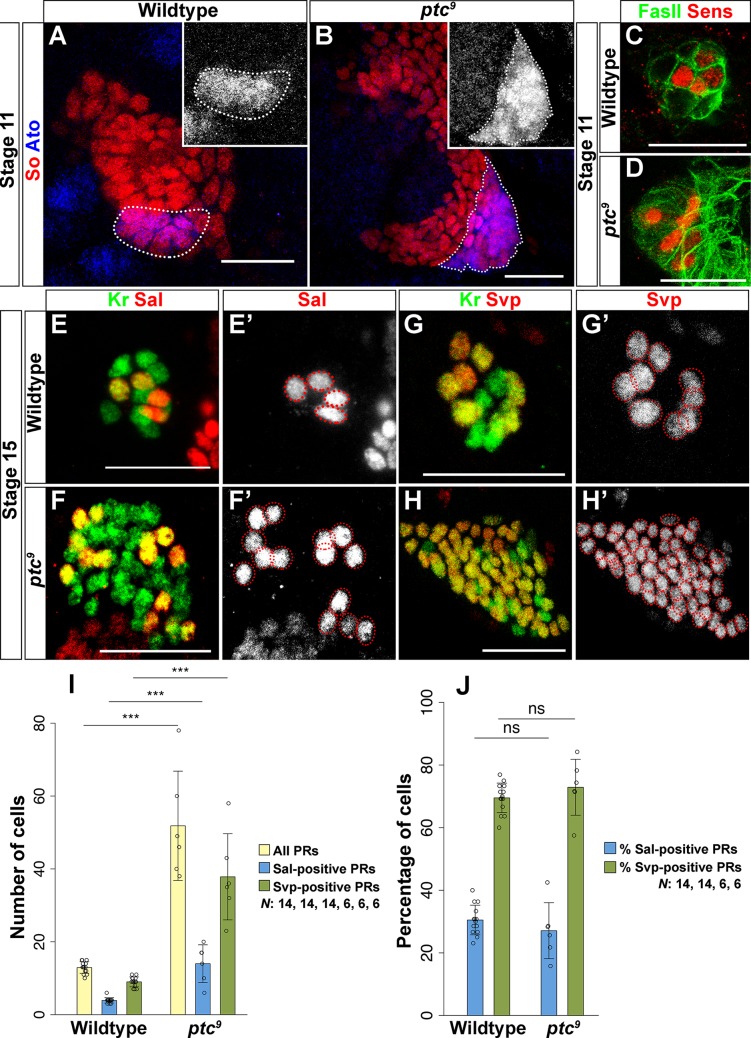
Hh regulates Ato- and Sens-dependent PR cell fate in the embryo.(A, B) Ato (blue) expression in the optic placode in wildtype and ptc9 mutant stage 11 embryos. So (red) marks cells of the entire optic placode at this stage. The number of Ato-expressing cells is increased in ptc9 mutants (B) as compared to wildtype (A). (C, D) Sens (red) expression in the PR precursors of wildtype and ptc9 mutant stage 12 embryos. FasII (green) marks differentiated PR neurons at this stage. The number of Sens expressing cells is also increased in ptc9 mutants (D). (E, E’, F, F’) Sal (red) expression in the PR precursors in wildtype and ptc9 mutant stage 15 embryos. Kr (green) marks PR precursors at this stage. The number of Sal-expressing primary PR precursors is significantly increased in ptc9 mutants (F’) compared to wildtype (E’). (G, G’, H, H’) Svp (red) expression in the PR precursors in wildtype and ptc9 mutant stage 15 embryos. The number of Svp expressing secondary PR precursors is also increased (H’), probably as a result in the increase of primary PR precursors (F’). (I, J) Quantification of PR cell number (I) and percentage of Sal- and Svp-positive PRs in the wildtype and ptc9 mutants (J). In ptc mutants more PR precursors are formed compared to wildtype control. Analyzing the subtype identity of these PR precursors, we found that the ratio of Svp- vs Sal-positive cells is the same in ptc mutants and in wildtype. Number of all PRs: wildtype vs ptc9 p<0.001, t = -14.768; Number of all Sal-positive cells: wildtype vs ptc9 p<0.001, t = -6.608; Number of all Svp-positive cells: wildtype vs ptc9 p<0.001, t = -14.428 (I). Ratio of Sal-positive cells: wildtype vs ptc9 p = 0.876, t = 0.887; Ratio of Svp-positive cells: wildtype vs ptc9 p = 0.967, t = -0.627 (J). n = 14 (wildtype), 6 (ptc9) (I, J). Data is shown as mean and error bars as standard deviation. Circles represent numbers or percentages of individual samples. *** p<0.001and ns = not significant (I, J). Scale bars represent 20 μm.